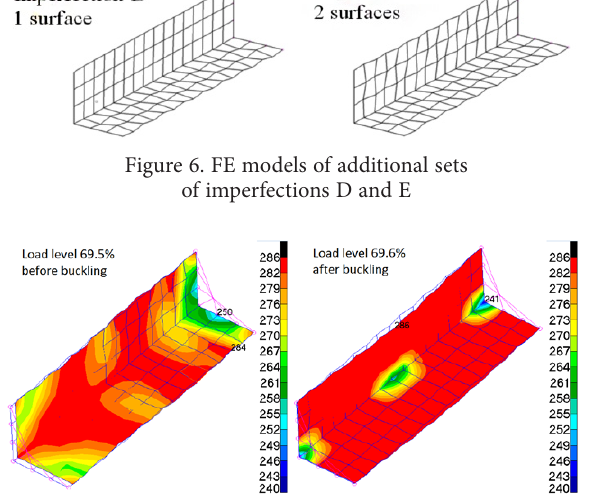
Figure 7. Graphic visualization of von Mises stress distribution on FE model with imperfection E